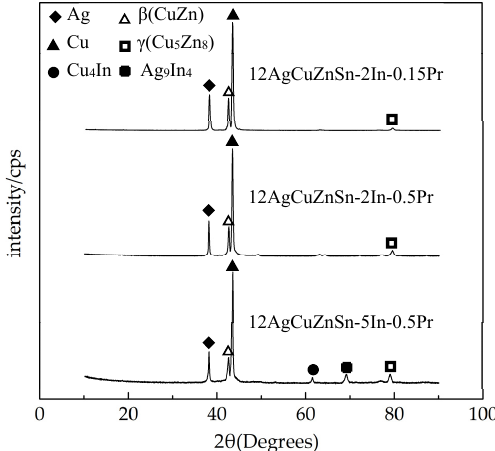
Figure 4. XRD pattern of the novel filler metals.